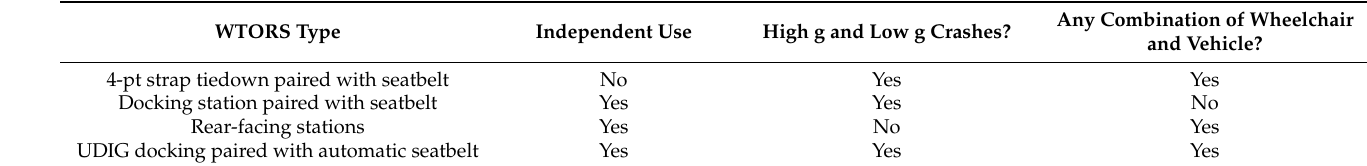
Table 1. Assessment of WTORS by independent use, crashworthiness level, and wheelchair/vehicle compatibility.